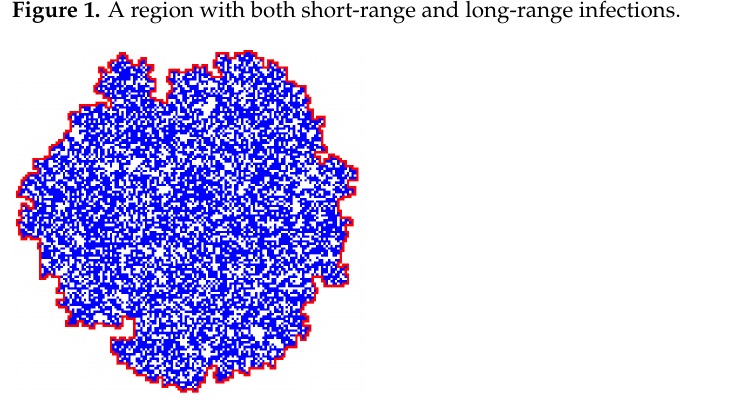
Figure 2. A locally infected region together with its rectilinear